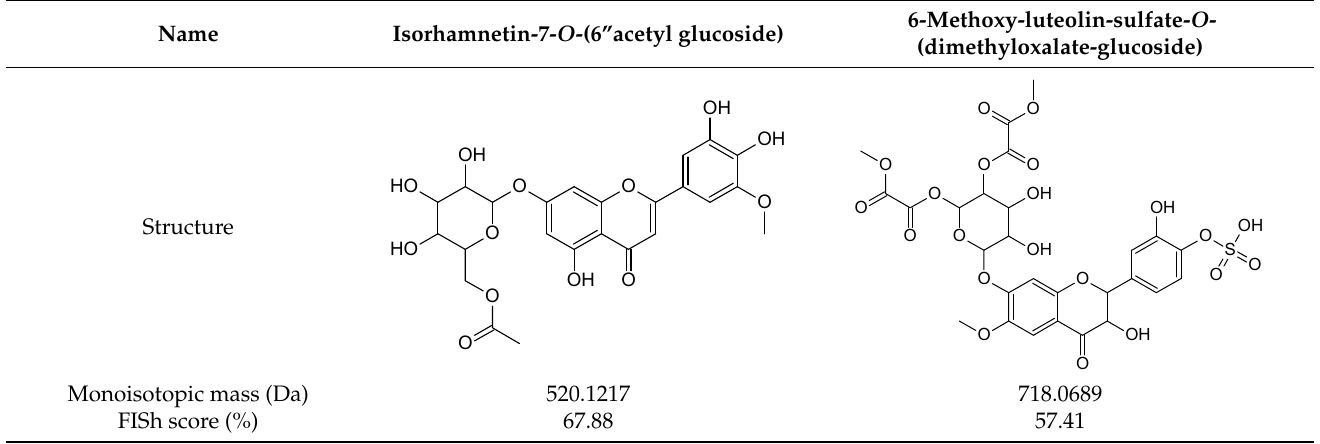
Table 4. Example of two hypothetical structures of candidate flavonoids detected in Salicornia plant.